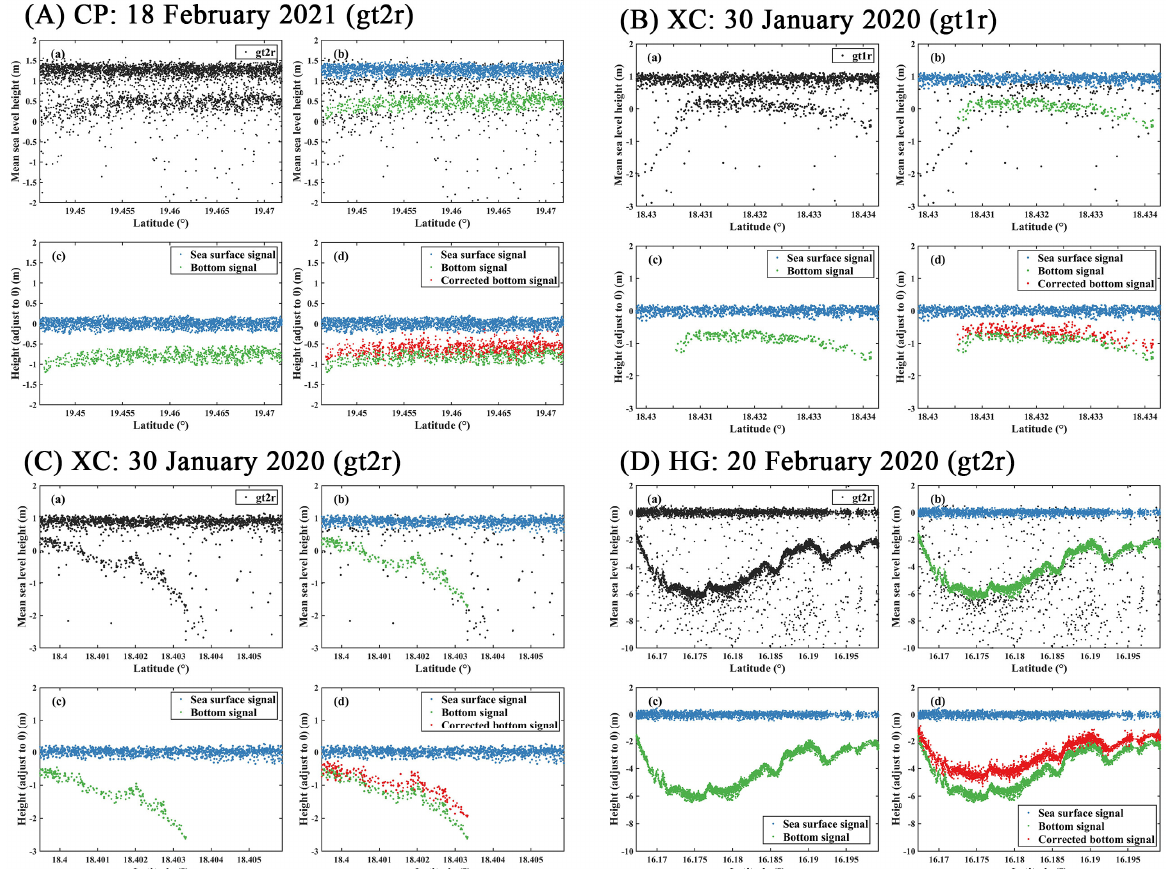
Figure 12. The bathymetric correction process for the three regions: ( A ) CP; ( B , C ) XC; ( D ) HG. For each graph, ( a ) is the photon orthometric height from ATL03 products, and the corresponding track is shown in the legend; ( b ) is the clustering result for all photons based on the DBSCAN method; ( c ) is the distribution of sea surface signals (blue dots) and the bottom signals (green dots) after DBSCAN clustering, noise removal, and sea surface adjustment to 0 m; and ( d ) is the corrected depth of bottom signals (red dots).